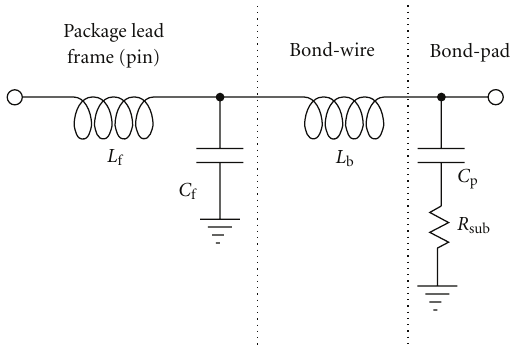
Figure 16: Lumped-element model of package pin, wirebond, and